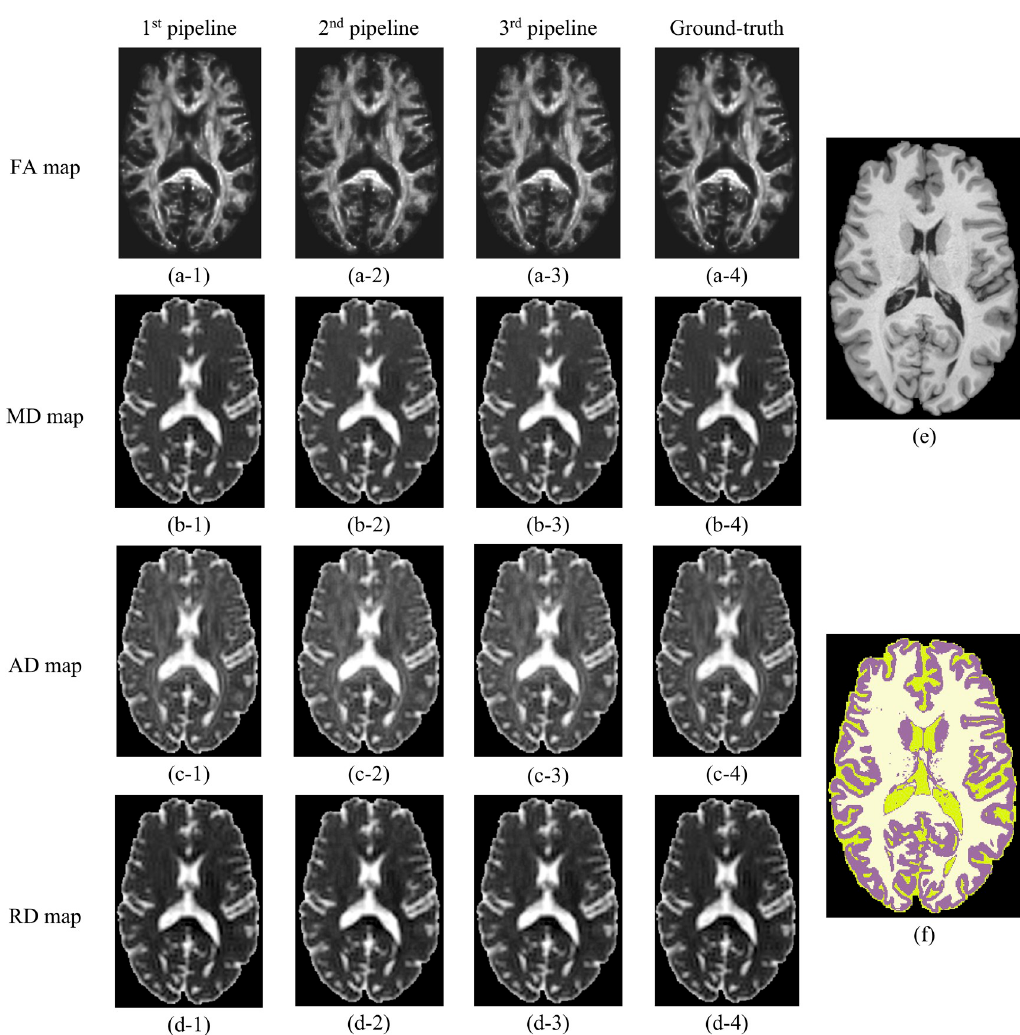
processing pipeline, respectively. The fourth column corresponds to the maps obtained directly from the ground truth data. (E) The corresponding T 1 -weighted structural image and (F) full-brain segmentation of cerebral tissues (WM, GM, and CSF) are also provided. The images were not